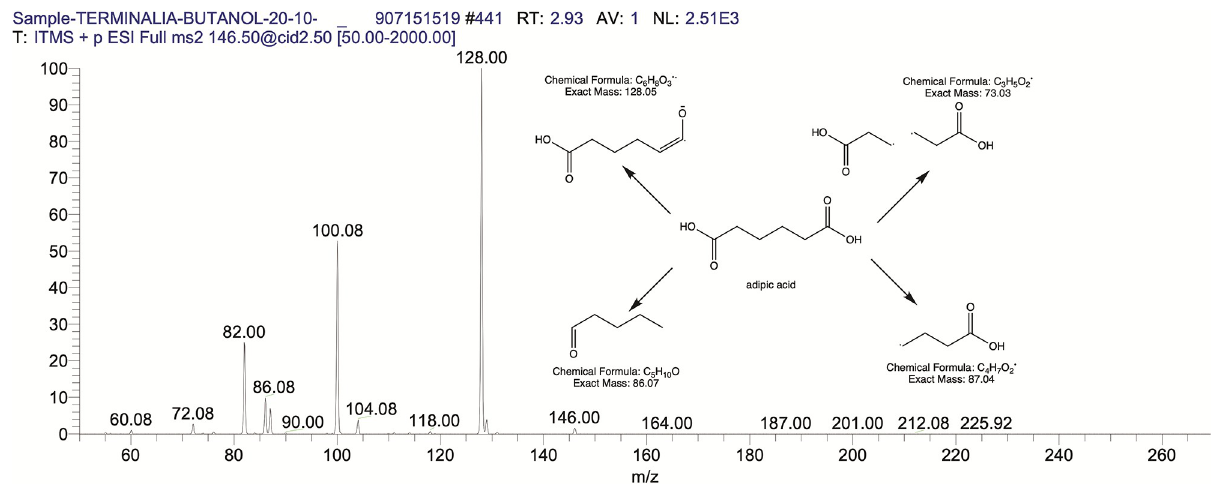
Fig 17. The mass spectrum of adipic acid and its fragmentation pattern.